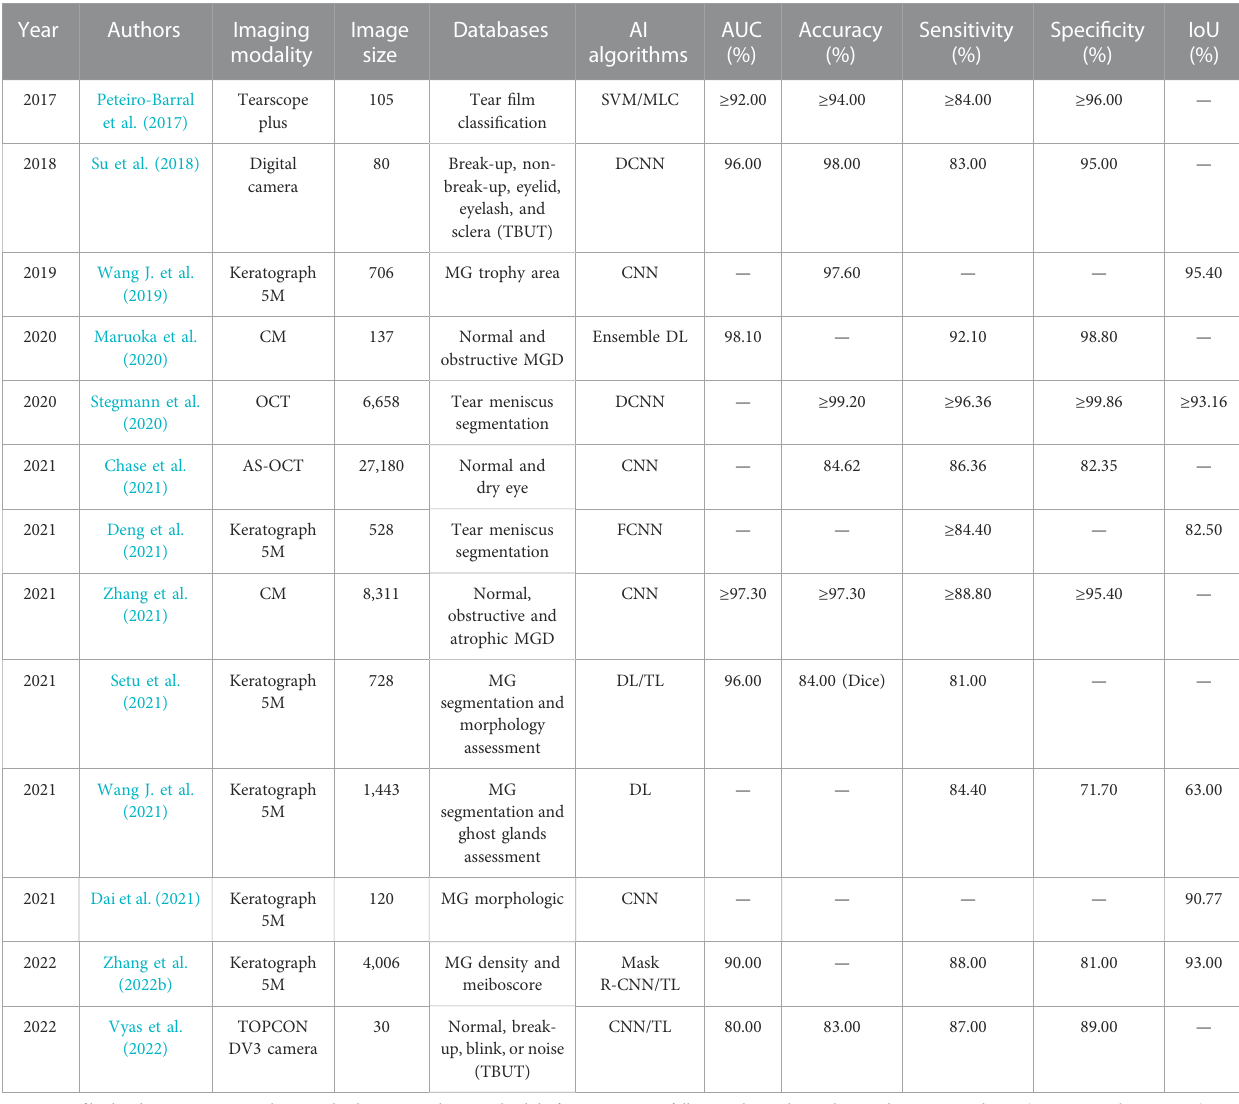
TABLE 4 Summary of studies focused on computer-aided dry eye